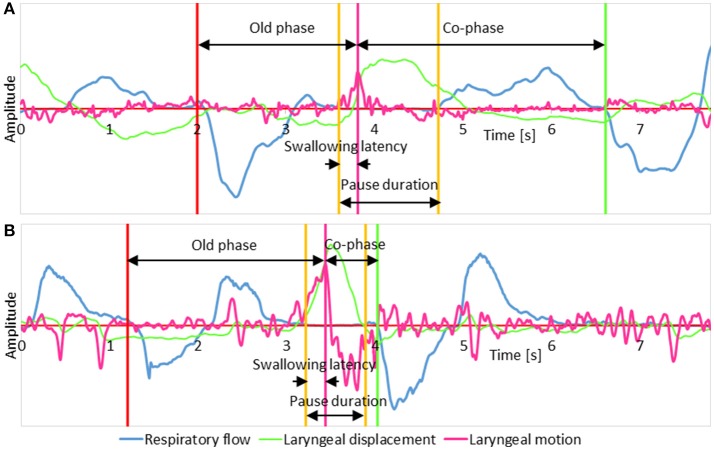
The schema illustrates parameters measured on signal traces. (A) A representative case of a swallow with the expiration-swallow-expiration pattern; (B) A representative case of a swallow with the expiration-swallow-inspiration pattern. In both traces, respiratory flow, laryngeal motion, and laryngeal displacement signals are shown in blue, magenta, and green, respectively. A positive shift in the respiratory flow signal represents expiration, and a negative shift represents inspiration. The laryngeal displacement signal was derived by integrating the laryngeal motion signal.